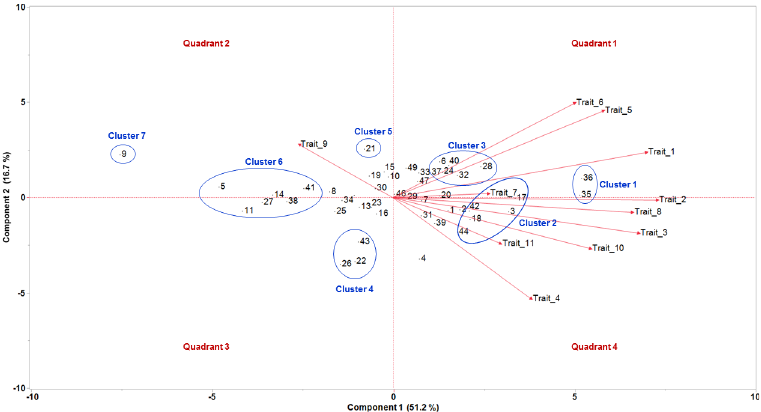
Fig 3. Principal component analysis biplot that separated the soybean genotypes in to clusters based on the root and shoot traits. Traits 1–11 are total root length, total root surface area, total root volume, average root diameter, fine root (diameter < 0.25 mm) length, fine root (diameter < 0.25 mm) surface area, root penetration, shoot dry weight, plant height, chlorophyll index, and seed size, respectively. Genotypes 1–49 are marked on the biplot; please see Table 1 for the genotype names corresponding to the